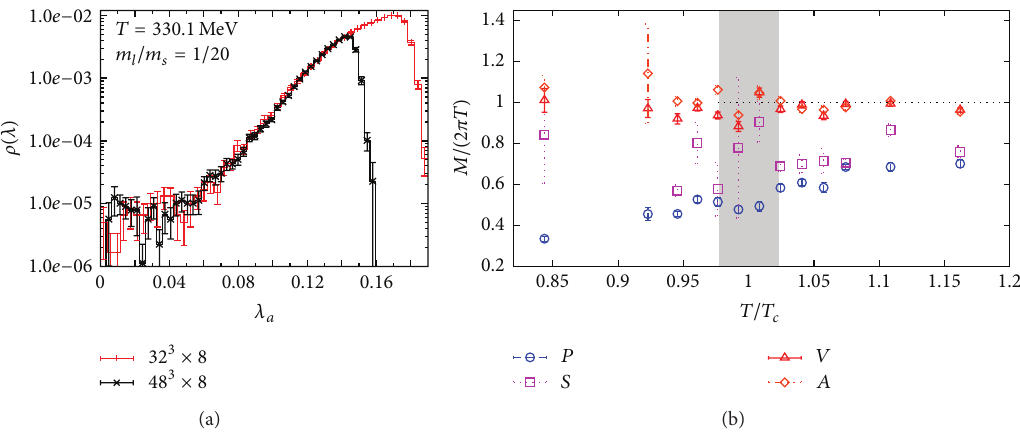
Figure 13: The density of eigenvalues at 𝑇 = 330.1 MeV for HISQ discretization showing a long tail even with large volumes, from [77] (a). In (b), the screening masses for scalar, pseudo-scalar, vector, and axial vector mesons using Wilson fermions are shown as a function of temperature, from